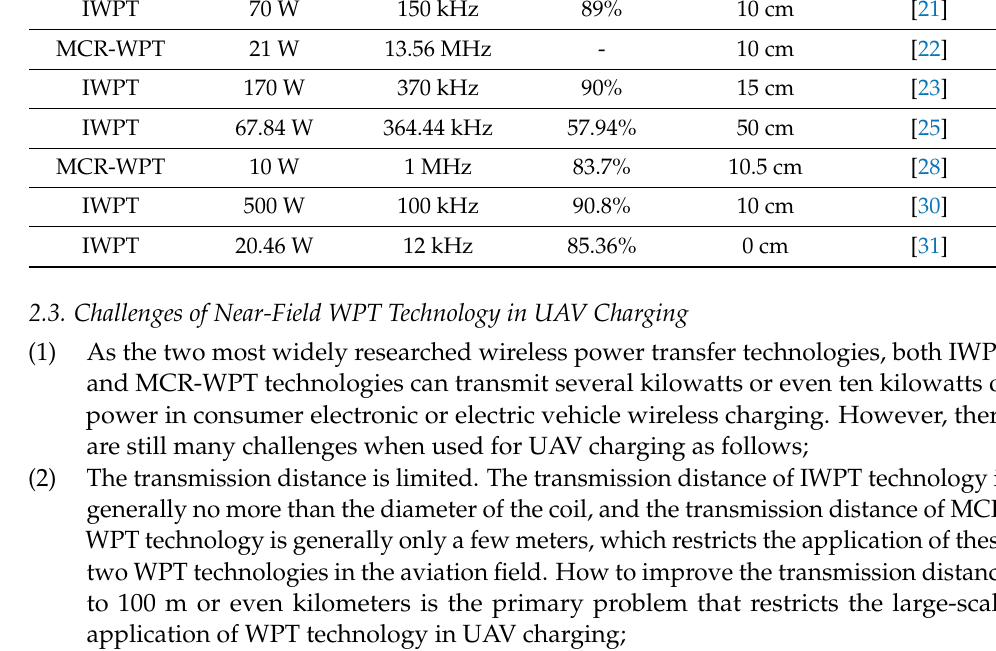
Table 1. Comparison of near-field WPT technologies used to power UAV.